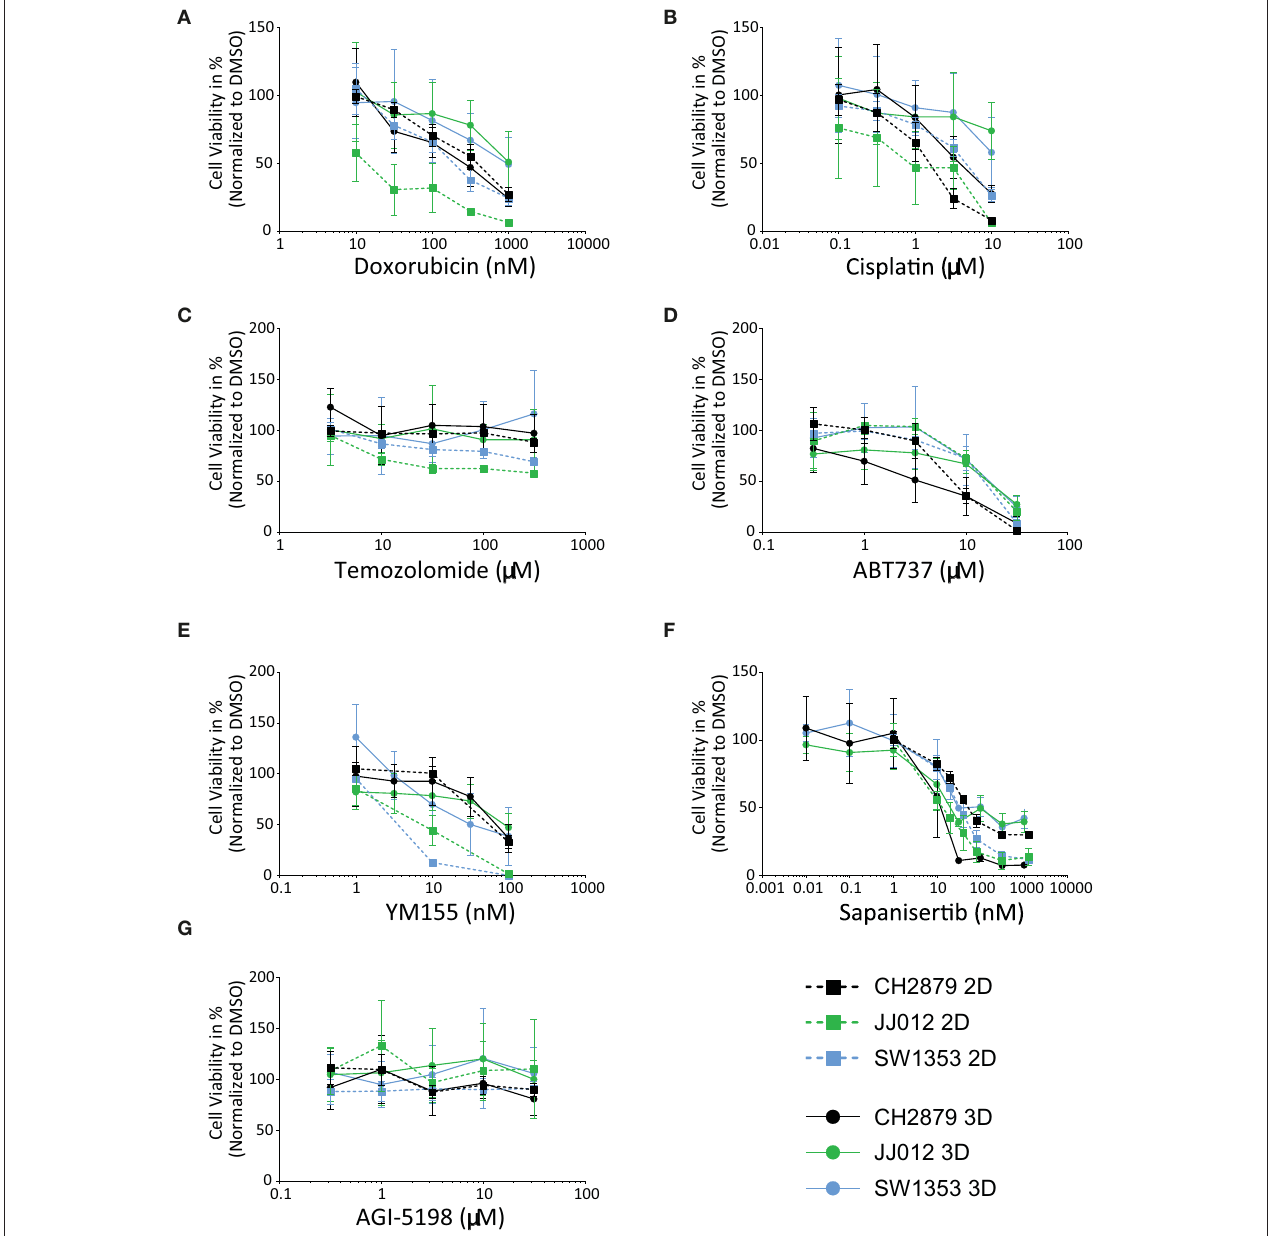
FIGURE 3 | Chondrosarcoma cell lines CH2879, JJ012, SW1353, cultured in 2D or 3D spheroid conditions, responded variably when treated with a panel of antineoplastic drugs; (A) Doxorubicin, (B) Cisplatin, (C) Temozolomide, (D) ABT-737, (E) YM-155, (F) Sapanisertib, (G) AGI-5198. For most compounds, cells in 2D are more sensitive as compared to 3D, with the exception of CH2879 when treated with doxorubicin or sapanisertib, CH2879 and JJ012 when treated with ABT-737- ( n ≥ 3). All results were normalized to DMSO/PBS control as applicable.